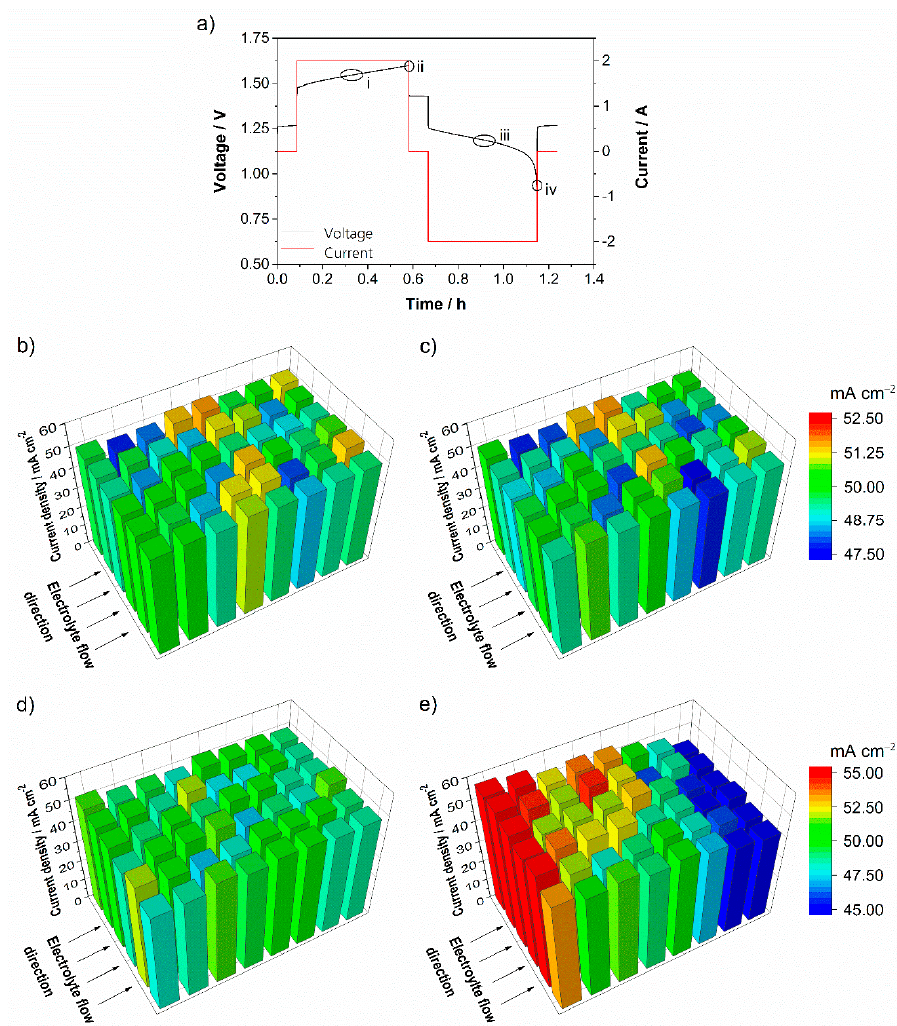
Figure 3. Current and voltage of the test cell during galvanostatic cycling ( a ) and current density distribution at di ff erent operating points at a current of 50 mA cm − 2 and an electrolyte flow rate of 2.5 mL min − 1 cm − 2 ( λ ≈ 60 at start): Charging around SOC 50% ( b ), close to the end of the charging process ( c ), discharge around SOC 50% ( d ) and close to end of the discharging process ( e ). The printed circuit board was installed at the cathode of the test